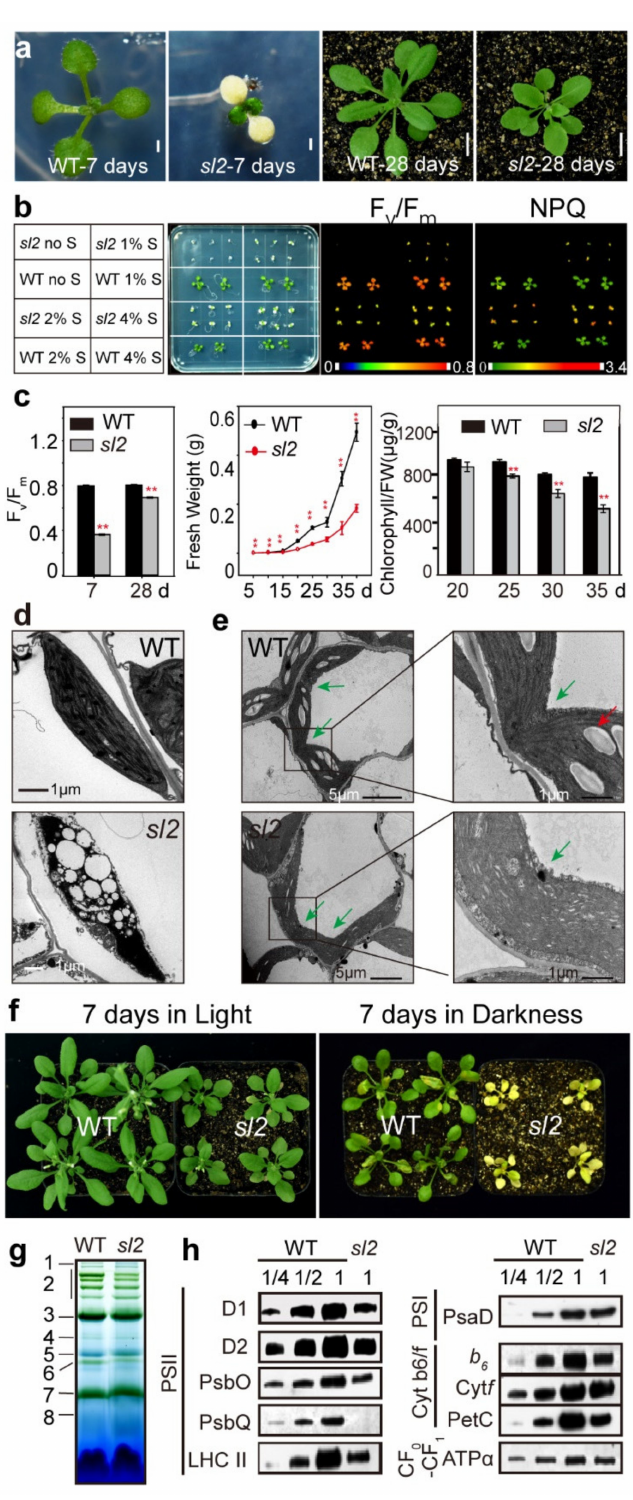
Figure 1. Phenotypic characterization of the sl2 mutant. ( a ) Seedlings of the wild-type (WT) and sl2 grown on 1 MS medium containing 1% sucrose for seven days (left, bar = 1 mm) and in soil for 2 28 days (right, bar = 1 cm); ( b ) Chlorophyll fluorescence images of the WT and sl2 seedlings grown on 1 MS medium without or with 1%, 2%, and 4% sucrose. The false-color images ranging from black (0) 2 to red (1) represent F v / F m , and green (0) to red (3.4) represent nonphotochemical quenching (NPQ); ( c ) The chlorophyll fluorescence (left), fresh weight (middle), and chlorophyll contents (right) of